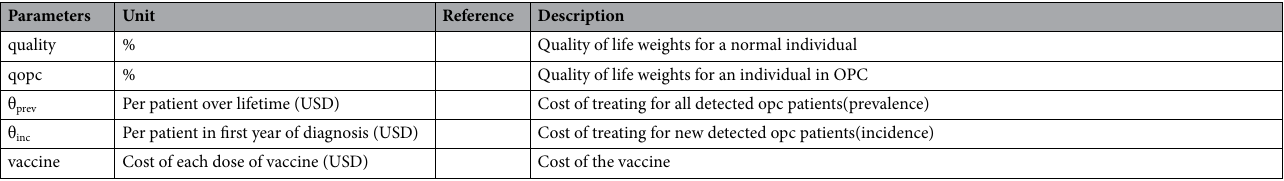
Table 6. Initial variables: definitions and sources of initial values (HPV, human papillomavirus; OPC, oropharyngeal cancer; DOPC, detected OPC; L, local; R, regional; D, distant; USD, U.S.